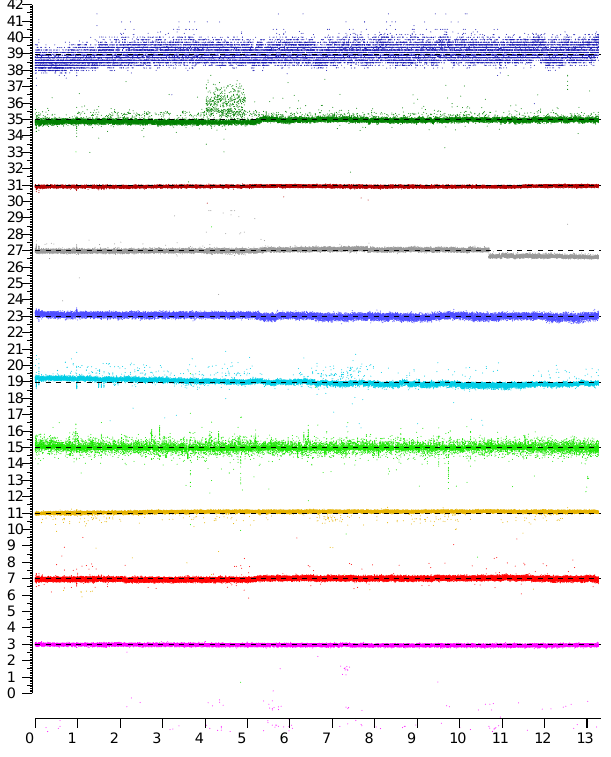
Figure 2. Sample measurements using ten different responders in fixed positions. (Top plot is for an access point operating in the 2.4 GHz band, the rest are in the 5 GHz band). Horizontal axis: time in hours. Vertical axis: distances in meters (individual plots are offset vertically to avoid